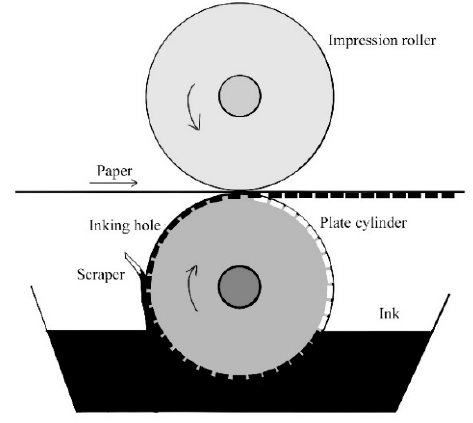
Figure 4. Gravure printing method.